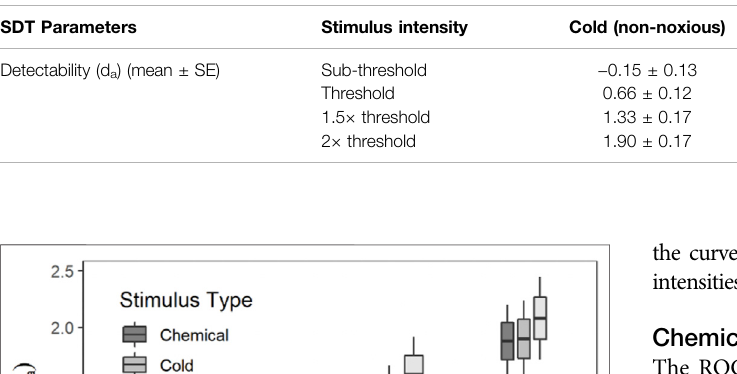
TABLE 3 | Average (±SE) d a for all three stimulus types and stimulus intensities.